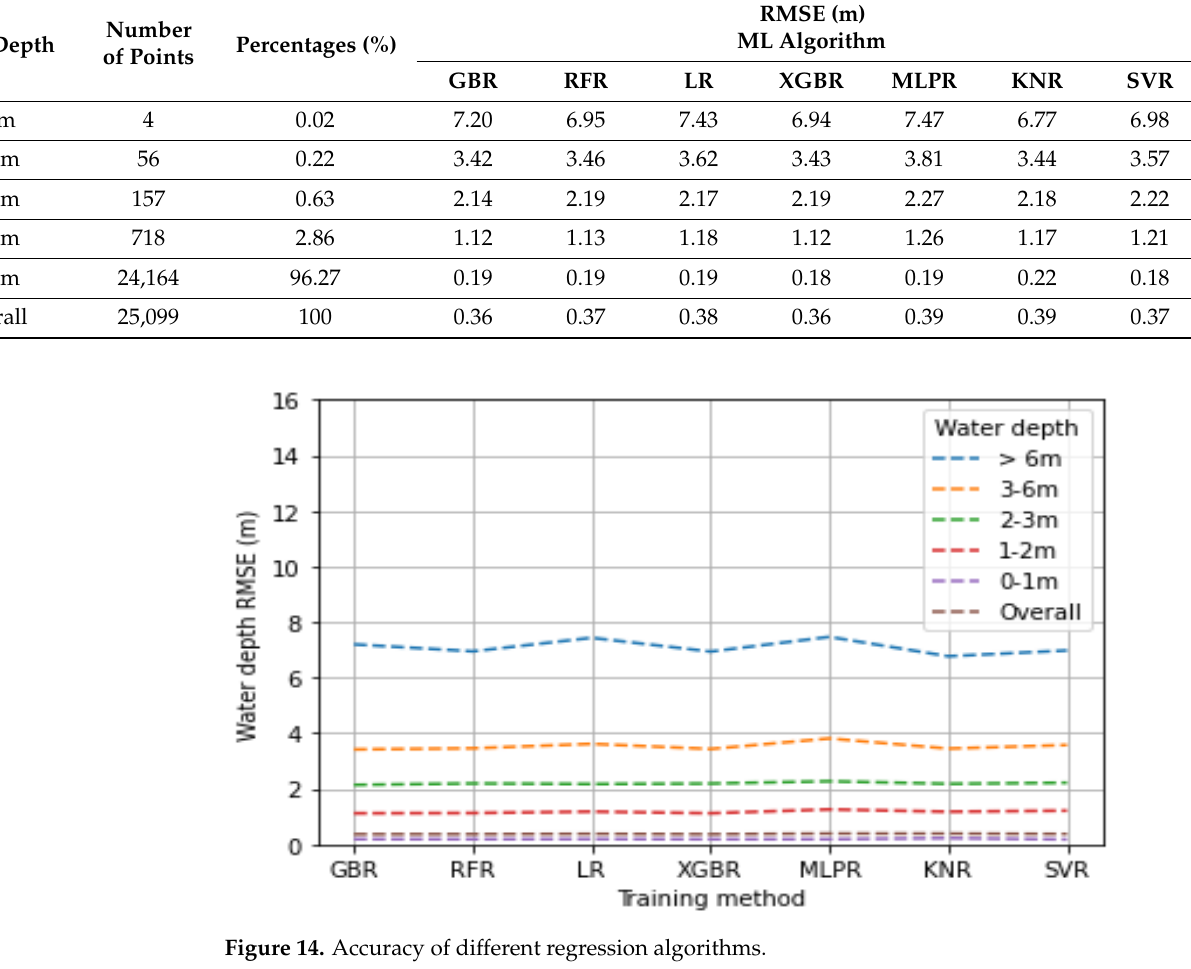
Figure 14. Accuracy of different regression algorithms.